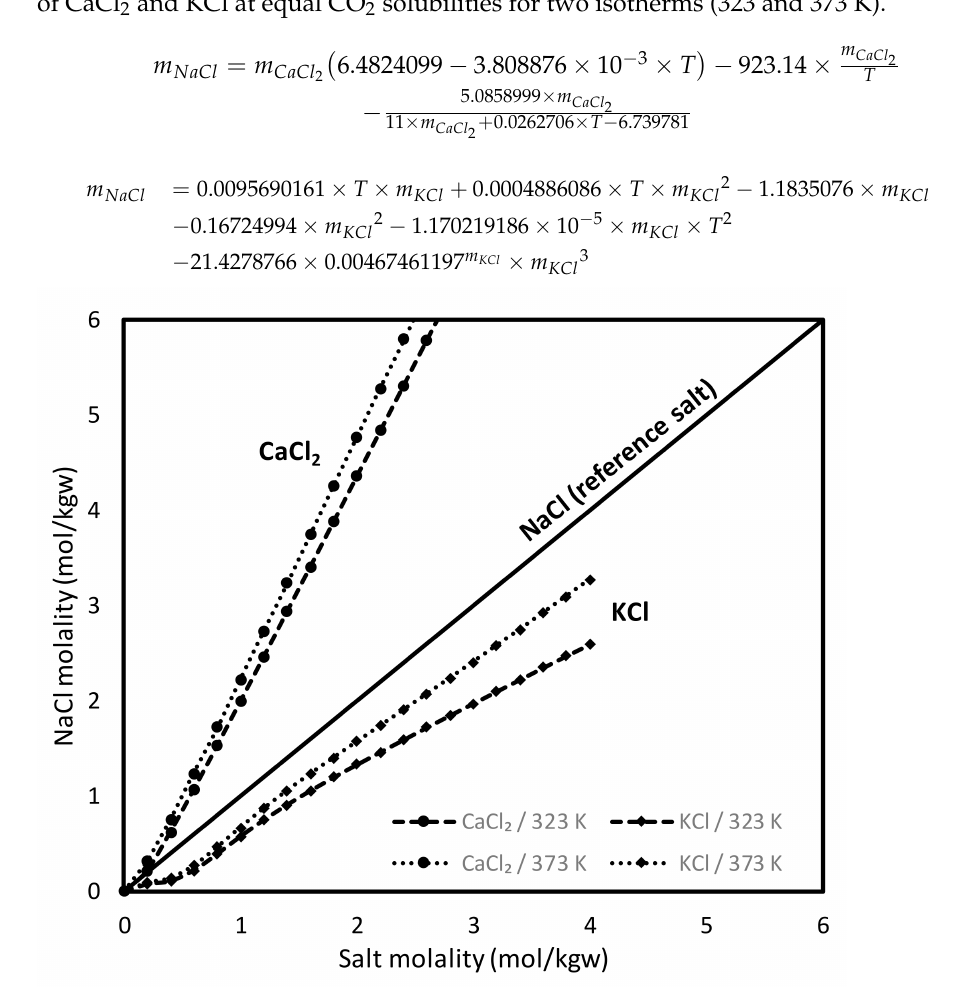
Figure 5. Duhring lines of equal CO 2 solubility in different brines (NaCl as the reference salt). In Figure 6, the solubility of CO 2 in CaCl 2 and KCl solutions calculated by the SW model using the Kij corresponding to each salt (Table 1) were compared to the calculations using their NaCl equivalent (with the help of Equations (19) and (20)) and the NaCl coefficients for the binary interaction parameter (Table 1). The results show a perfect adequacy between the calculations by the “apparent” molality and those by the “real” Kij corresponding to each